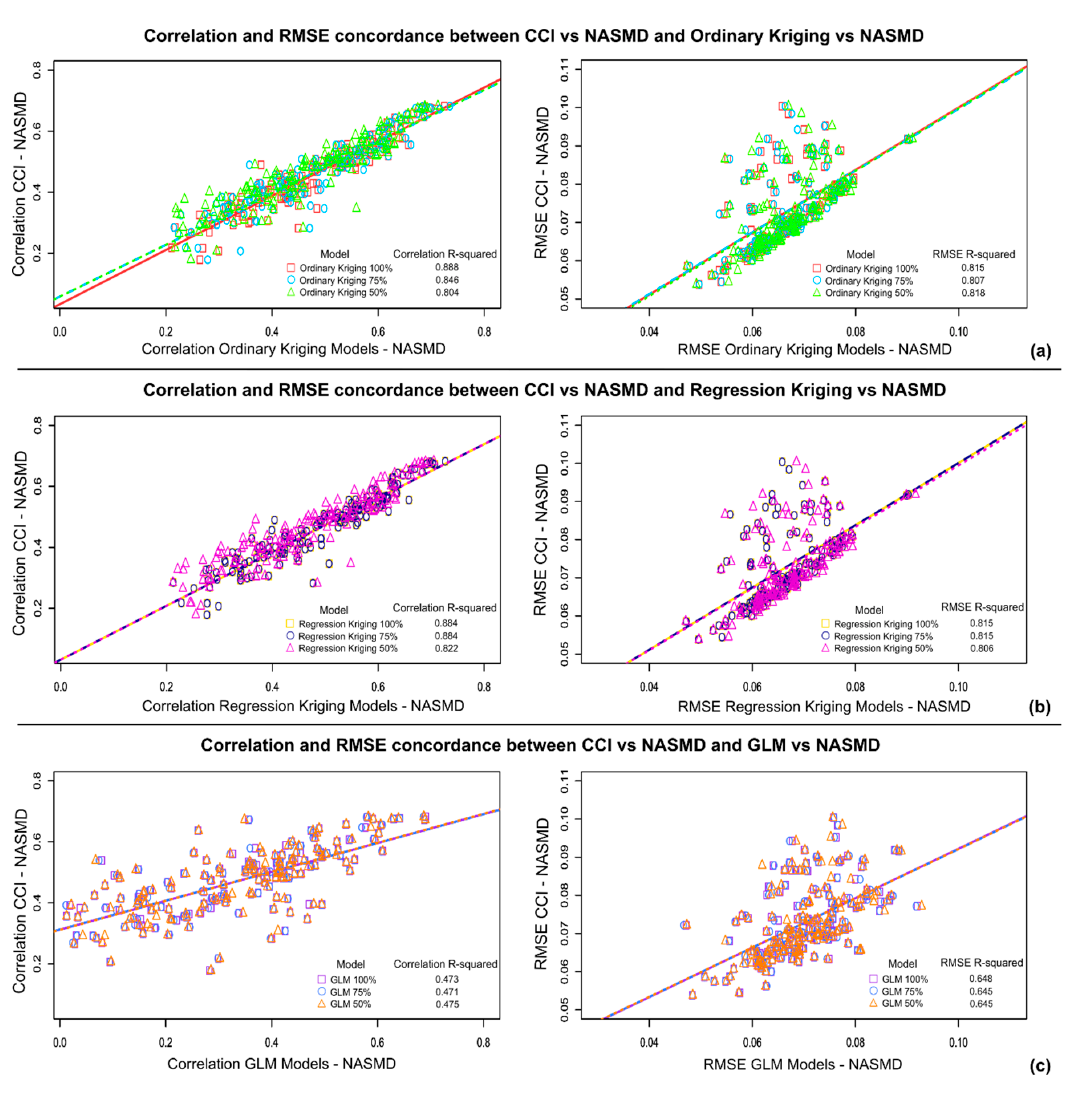
Figure 9. R-squared values showing the concordance between the reference validation (CCI-NASMD) and the validation of proposed gap-filling methods with NASMD. Each point represents one month, using 100%, 70%, or 50% of the available data, with the percentage indicated by the shape used. ( a ) Validation of ordinary kriging with NASMD, with correlation on the left and RMSE on the right; ( b ) Validation of regression kriging with NASMD, with correlation on the left and RMSE on the right; ( c ) Validation of GLM with NASMD, with correlation on the left and RMSE on the right. Regression lines between correlated datasets are shown in each plot.